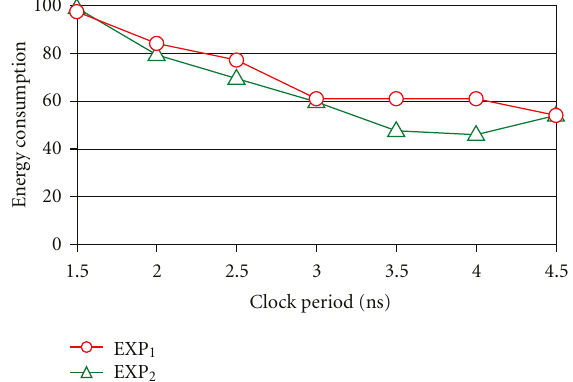
Figure 11: Energy consumption when the synthesis is constrained by the small set of operators for low-precision profile—65 nm ASIC